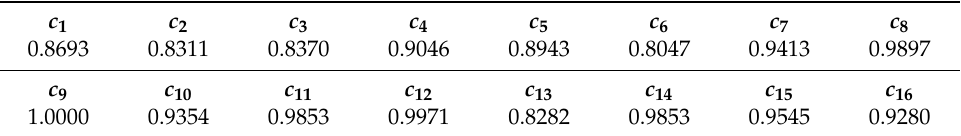
Table 2. The related weight of each criterion.